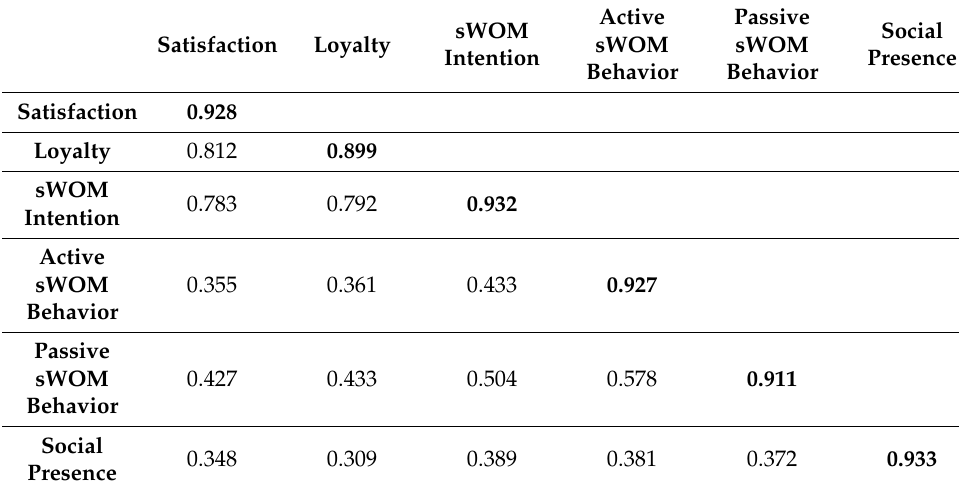
Table 4. Discriminant validity.